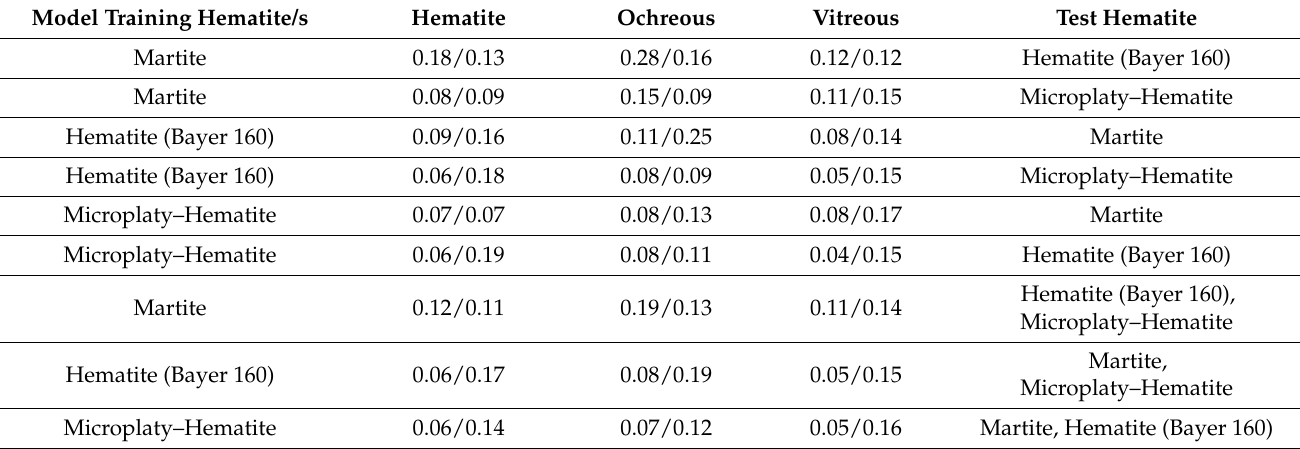
Table 4. The RMSE and standard deviation from 13 leave-one-or-many-out scenarios. The endmember exclusions are for hematite only. Column 1 is the hematite endmember, or members, used to train the model and column 5 is the hematite endmember, or endmembers, used to assess the model against. Columns 2–4 are the RMSE values for a given scenario with the RMSE values in the hematite, ochreous and vitreous columns in an X/Y format. The second value is the RMSE if a traditional linear mixing method is used, namely, mixtures calculated with the reflectance rather than the pseudo